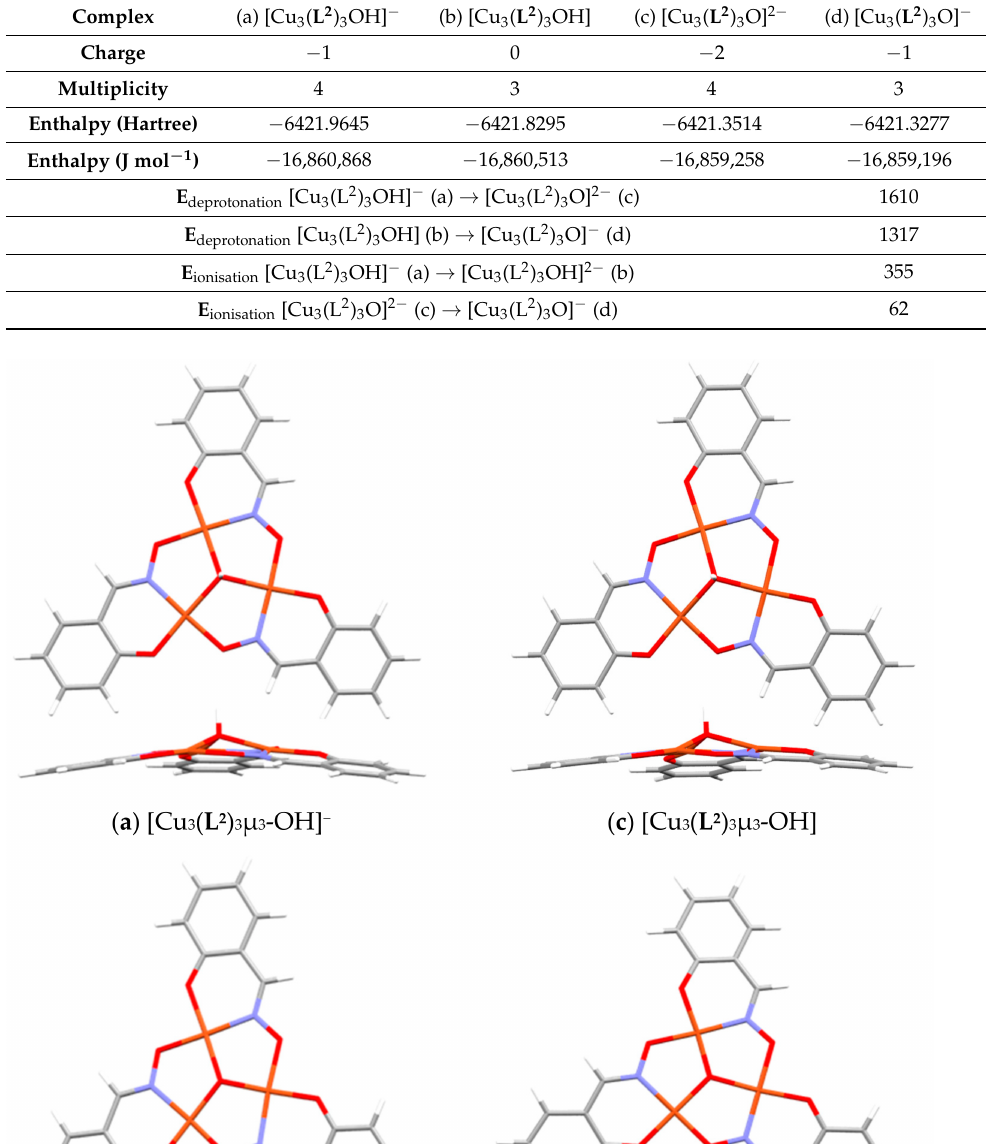
Table 3. The relative enthalpic energies of the µ 3 -hydroxo complexes (a) [Cu 3 ( L 2 ) 3 OH] − and (b) [Cu 3 ( L 2 ) 3 OH] and the µ 3 -oxo complexes (c) [Cu 3 ( L 2 ) 3 O] 2 − and (d) [Cu 3 ( L 2 ) 3 O] − and the calculated